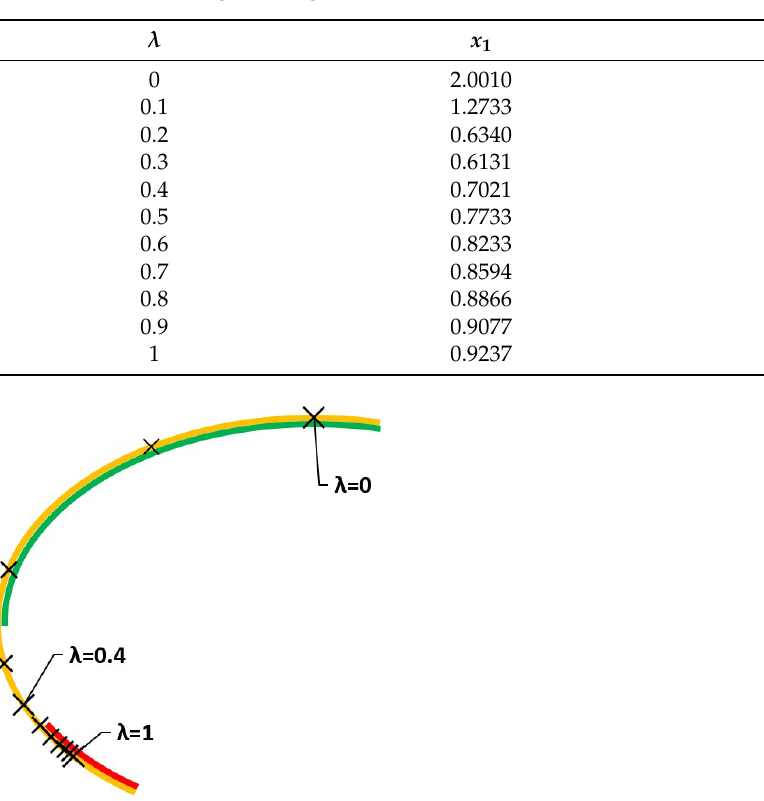
Table 1. Solutions using the weighted sums method.